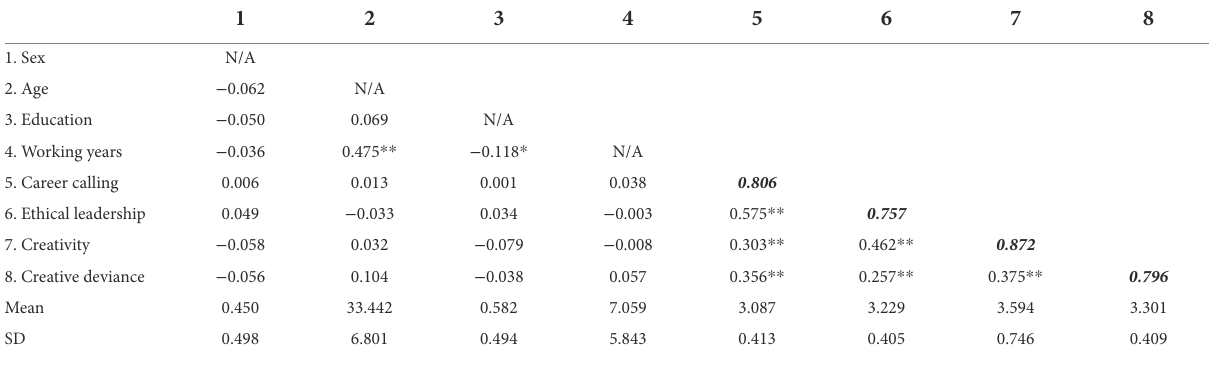
TABLE 2 Mean, standard deviation and correlation coefficient matrix.